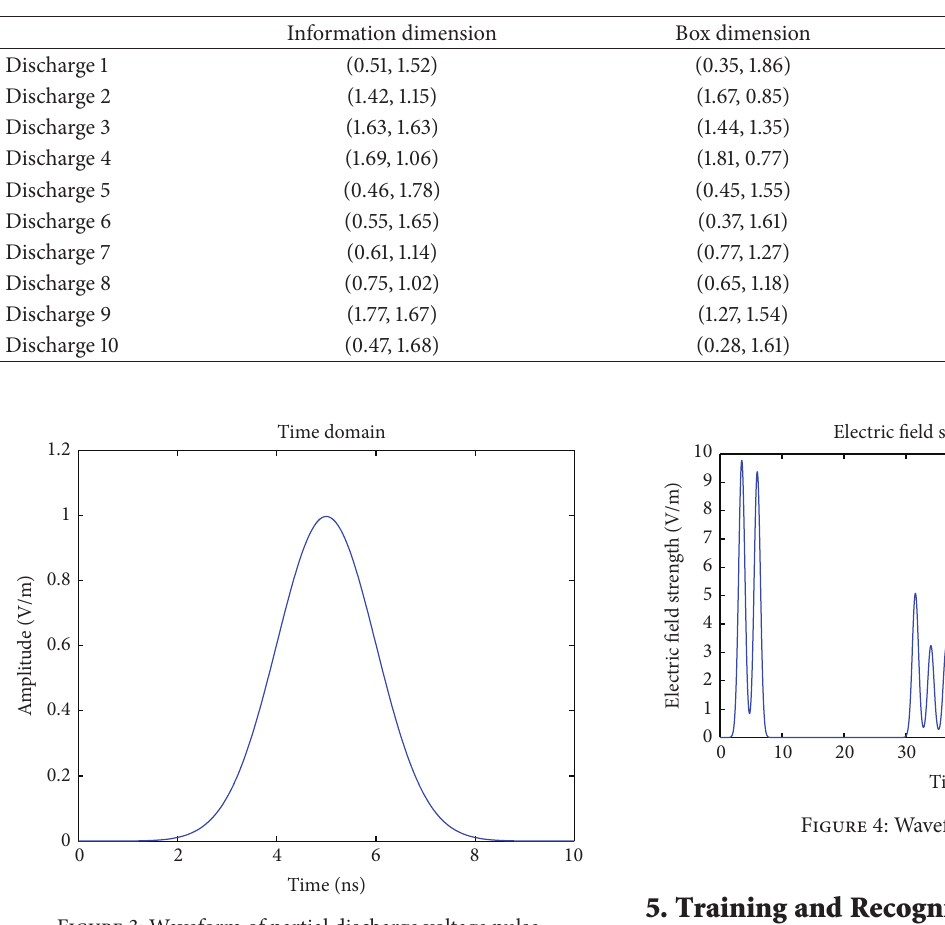
Table 2: Real data of discharge signals recorded.